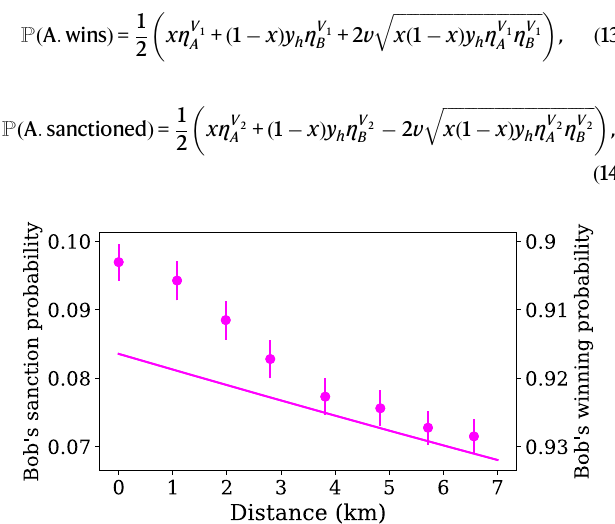
Fig.5|ProbabilitiesofBobwinningorbeingsanctioned,whenheisperforming an optimal attack, measured for different communication distances between AliceandBob. Onlyonesetofpointsisshownforthetwoaxes,asthesetwoevents are complementary. The line is plotted from Eqs. (11) and (12), with η s A given in Table 1. The error bars are mainly due to error propagation on this ef fi ciency. The observed deviation from the theory is linked to systematic errorswhen setting the re fl ectivities, which is discussed in Supplementary Note 2.